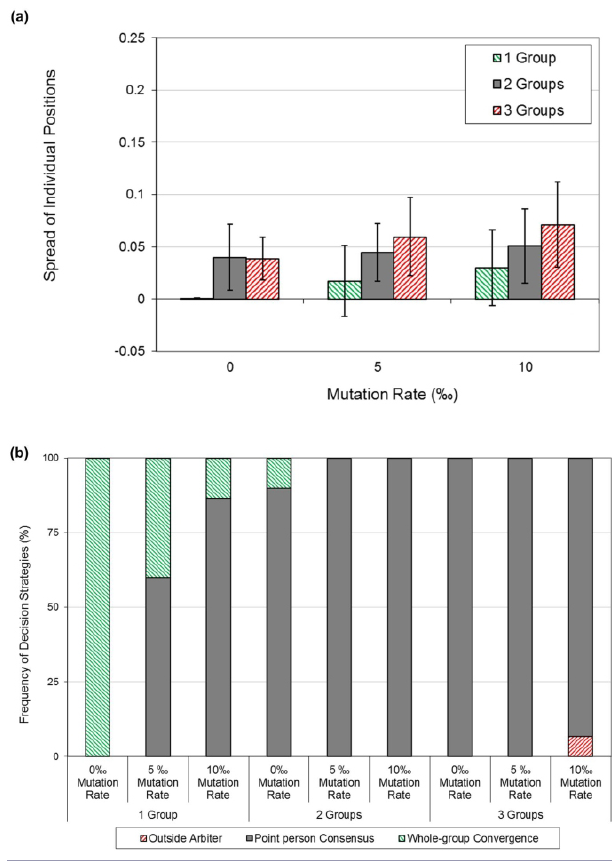
Fig. 7 . Effect of mutation probability on: (a) the spread of individual positions and (b) decision strategies. Error bars are + 1